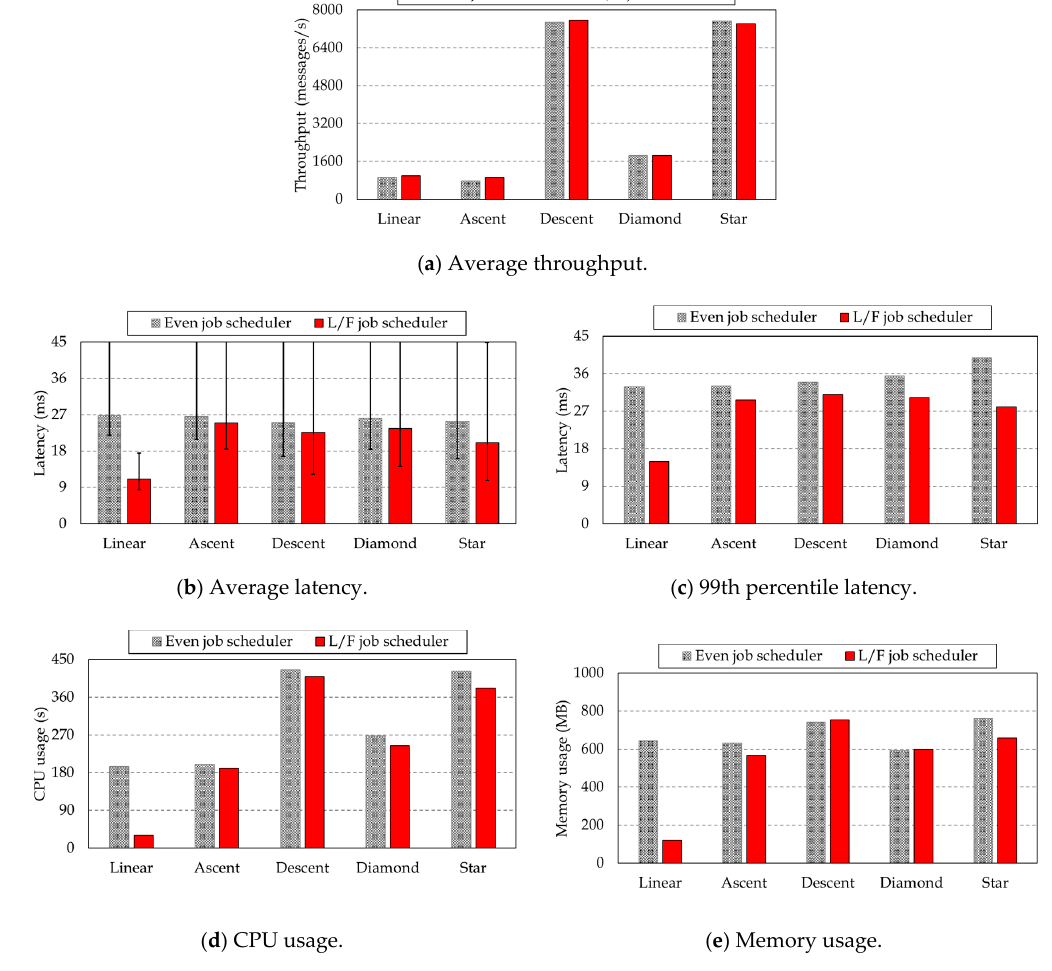
Figure 9. Performance of even and L/F job schedulers with non-LSP applications in low parallelism.